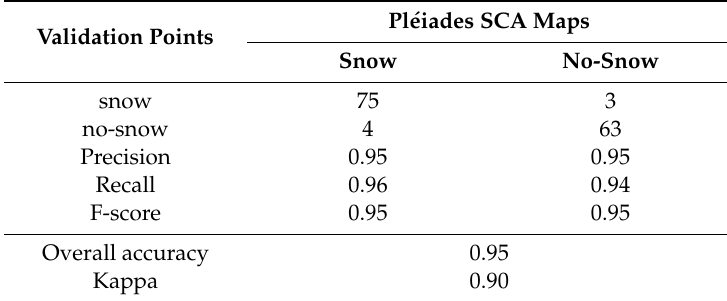
Table 2. Evaluation of the Pl é iades SCA maps with the validation